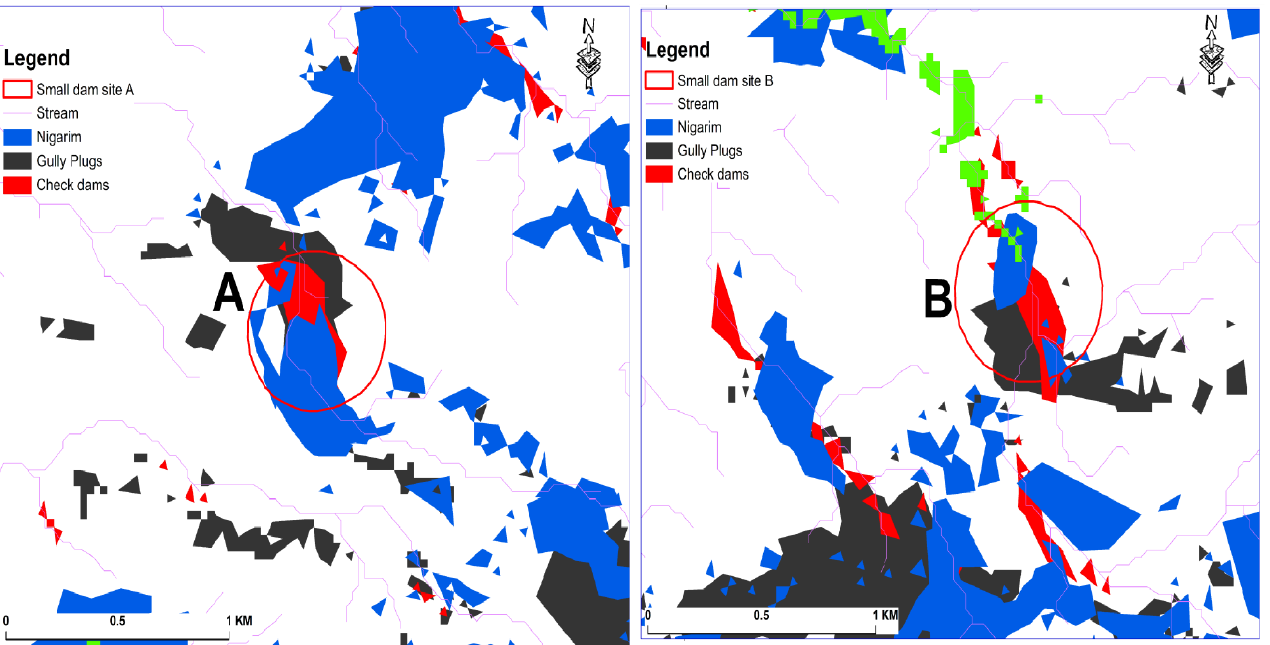
Figure 14. Composite map: suitable sites identified for construction of farm ponds, Nigarims, gully plugs, and check dams.